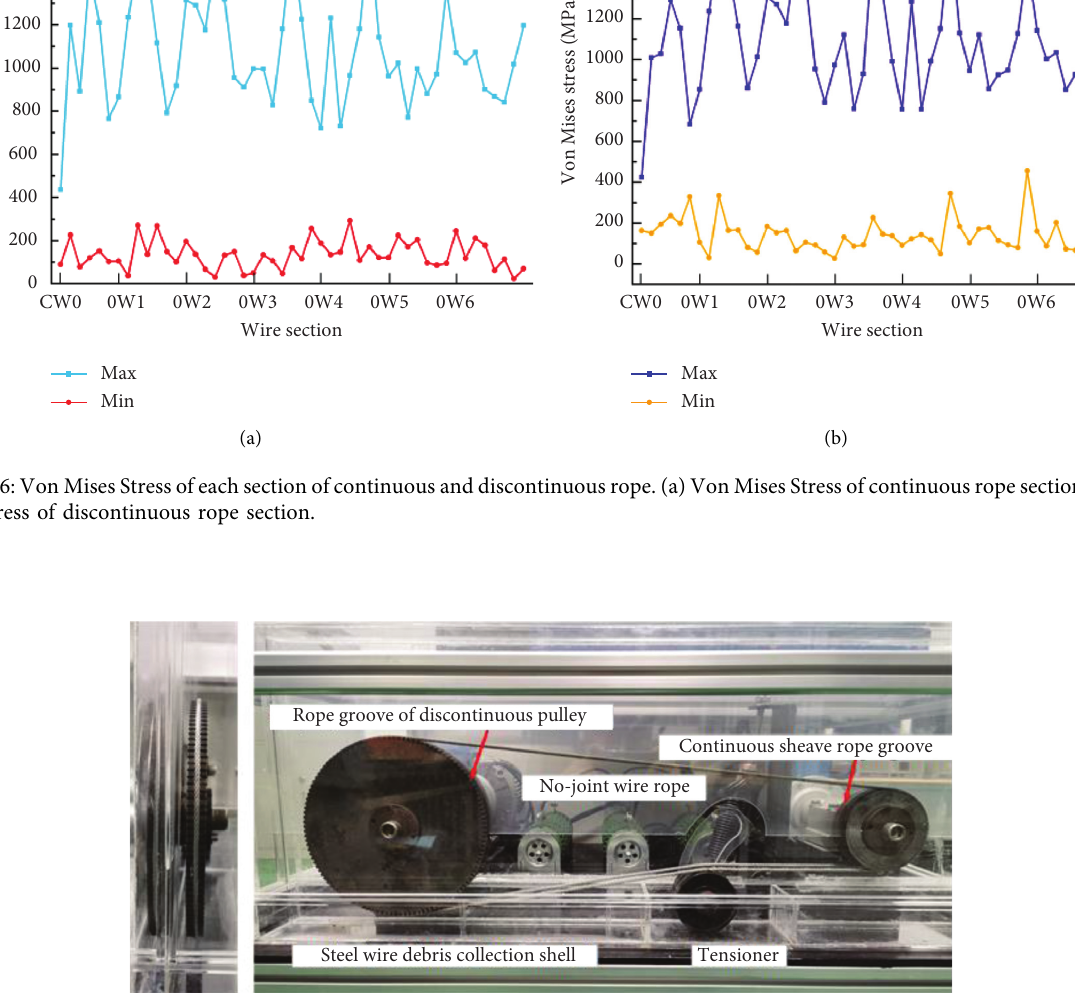
Figure 17: Continuous contact and discontinuous contact test bench for steel wire